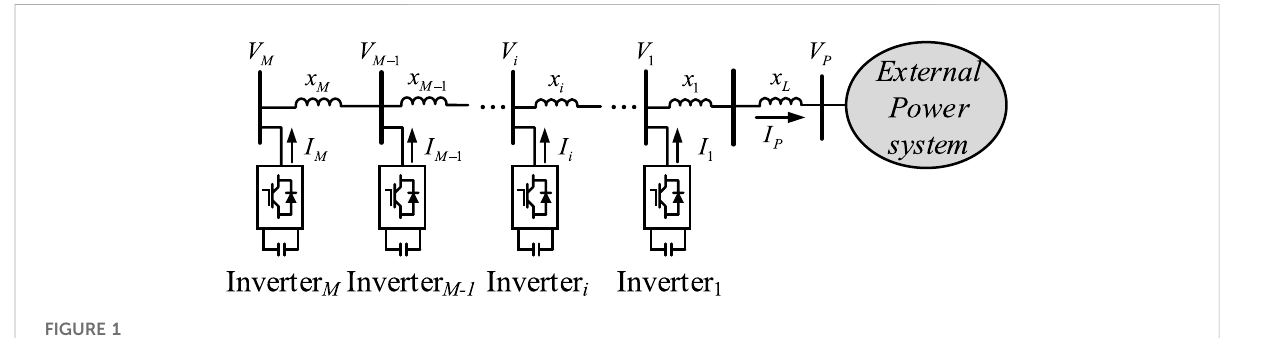
FIGURE 1 Cluster of M inverters in daisy-chain